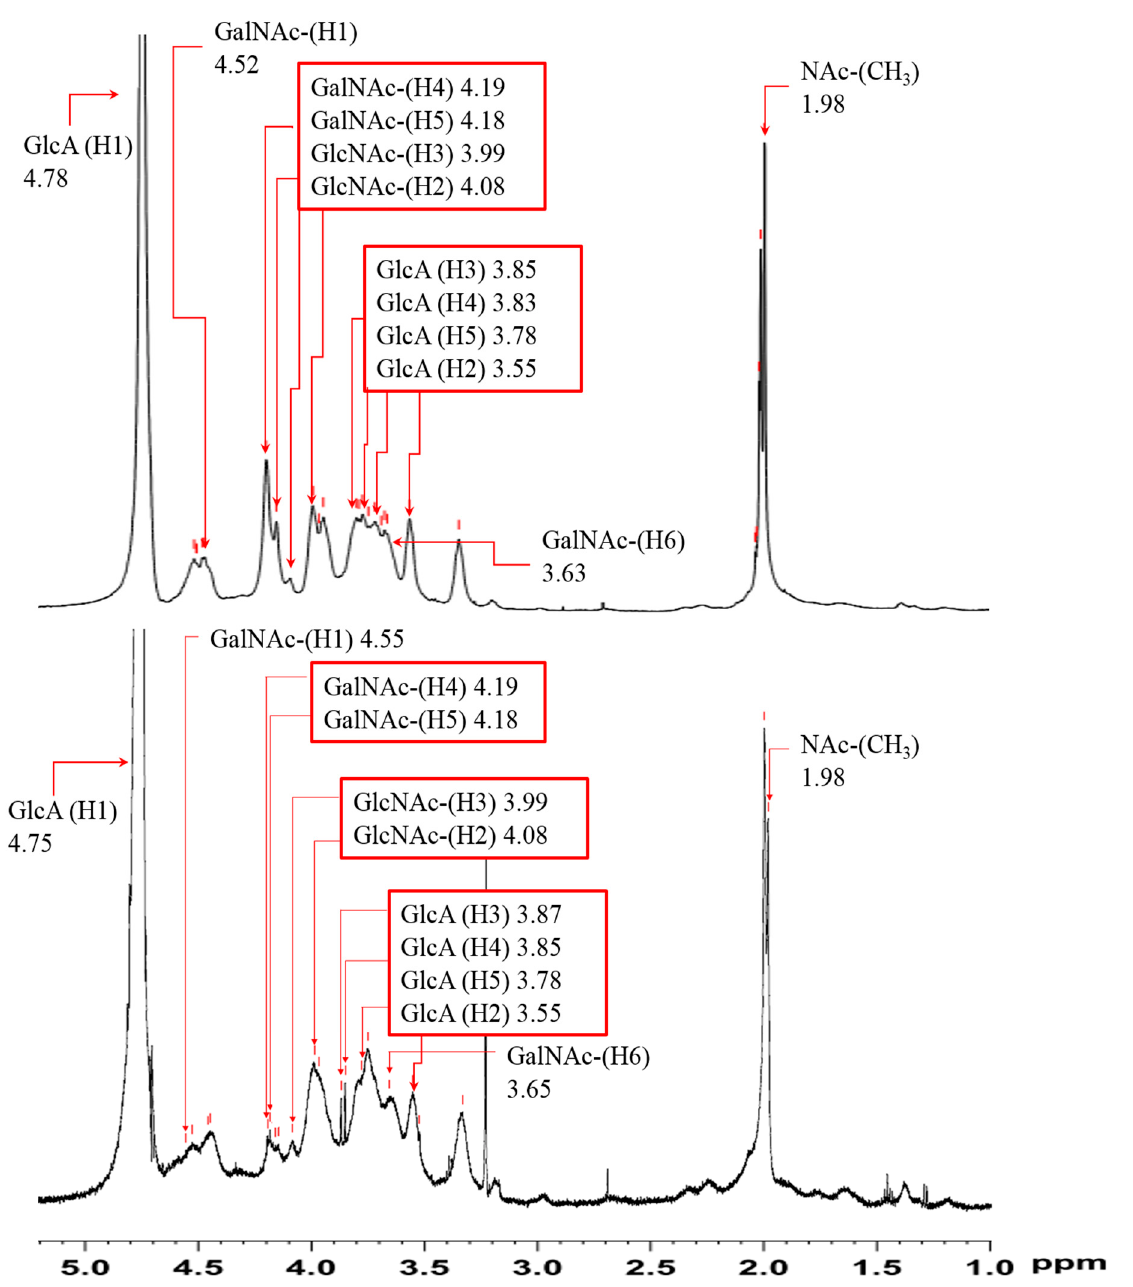
Figure 7. 1 H NMR spectrum of ( a ) ChS standard and ( b ) purified ChS measured at 600 MHz. Table 5. 1 H NMR (600 MHz) chemical shift of purified jumbo squid ChS.